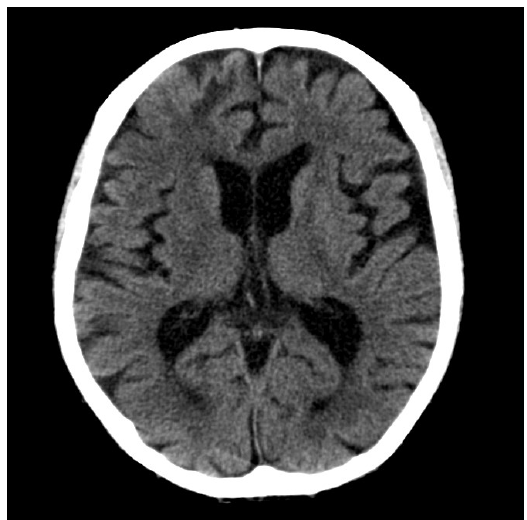
Figure 4. There was no significant lesion in the head computed tomography.